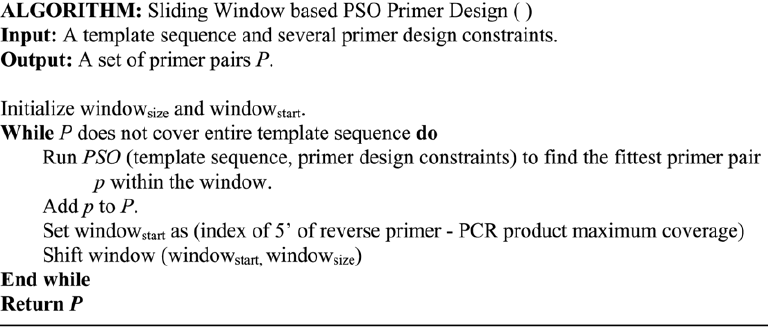
Figure 5. Pseudo-code of the sliding window based PSO primer design.